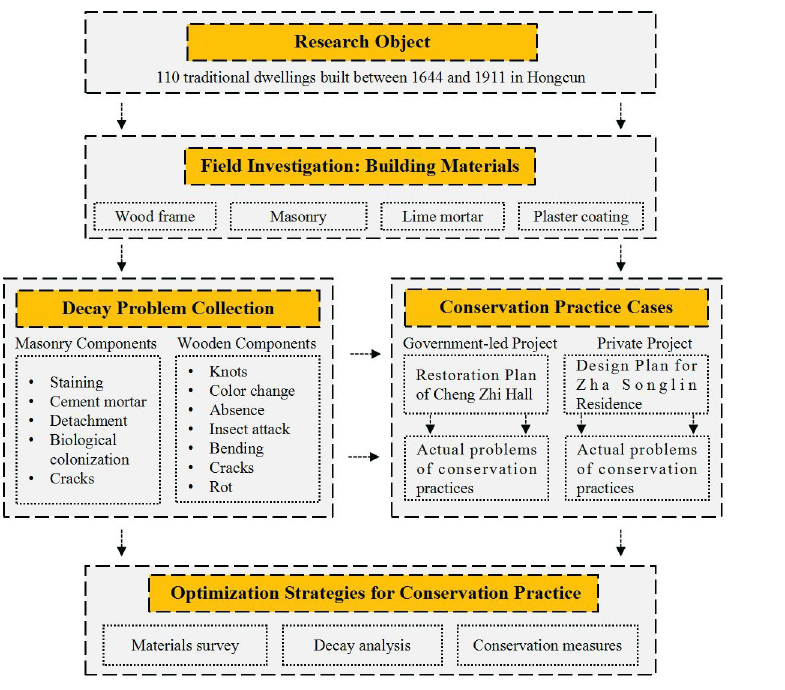
Fig 2. Schematic of the research program followed in this study. Source: Drawn by